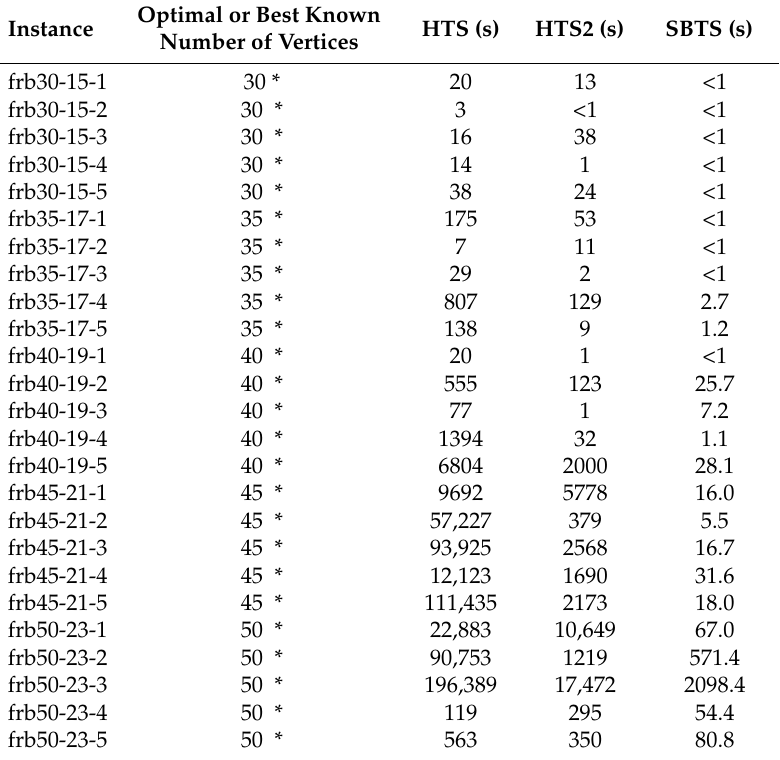
Table 5. Comparison of run times to find optimal solution of BHOSLIB instances for HTS, HTS2, and SBTS (Swap-Based Tabu Search). * denotes that the best known result is optimal.